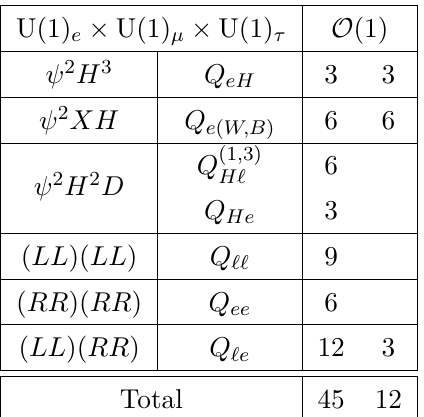
Table 7 . Counting of the pure lepton SMEFT operators (see appendix A) assuming U(1) 3 in the lepton sector. Since the U(1) 3 symmetry is exact (no spurions), the counting is presented for V the O (1) operators only. The left (right) entry in each column gives the number of CP even (odd) coefficients at the given order in spurion